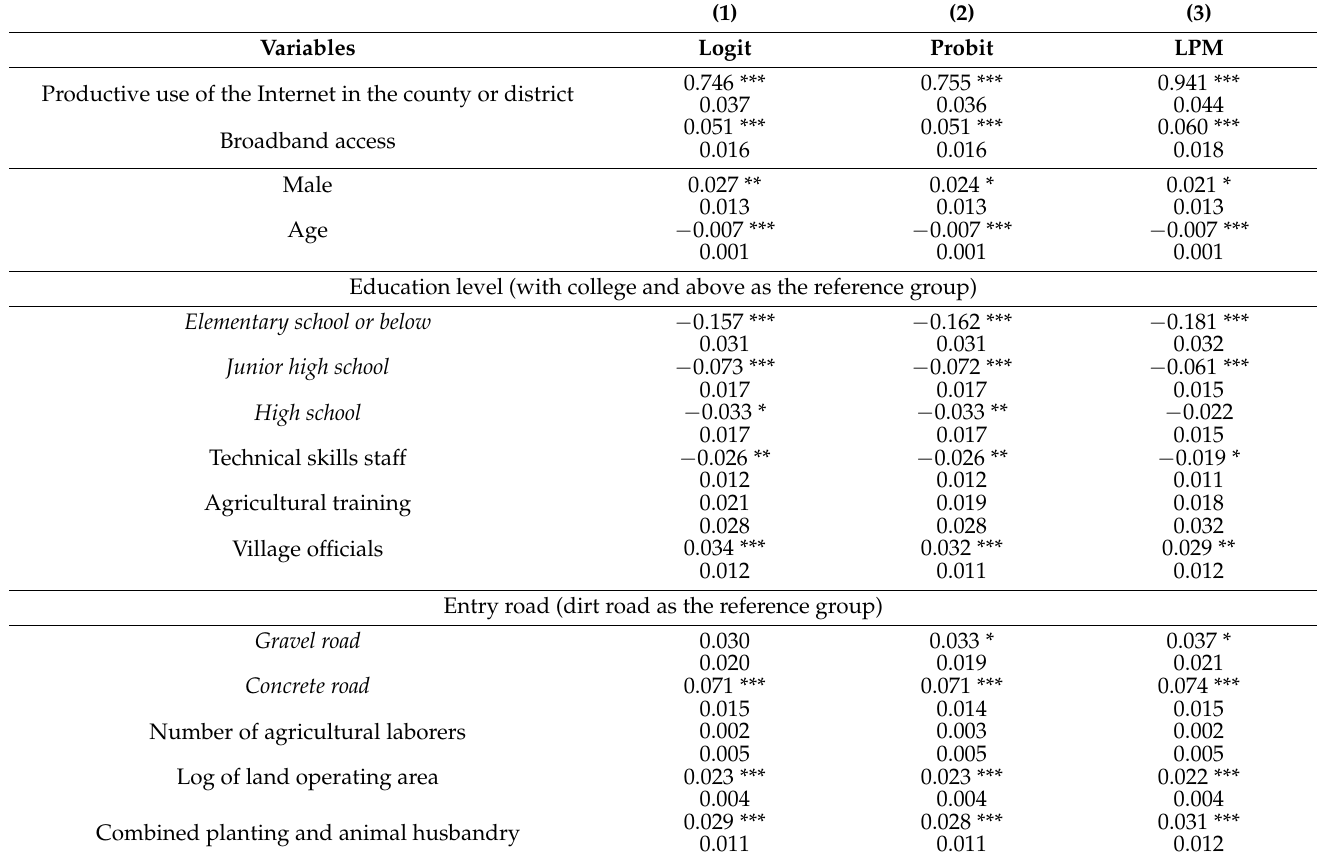
Table 4. The marginal effect of different variables on the selection of productive use of the Internet from Logit, Probit, and LPM